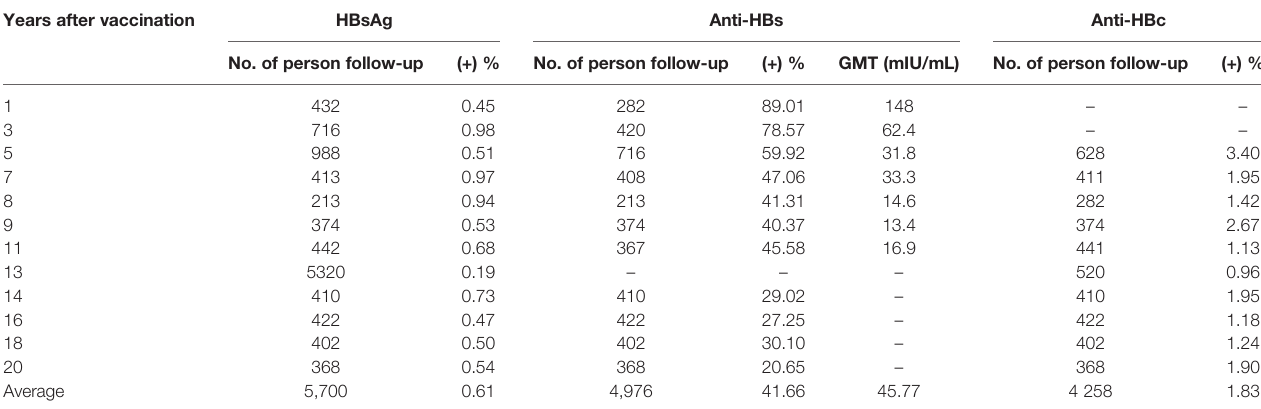
using joint-point regression analysis. Regression coef fi cient b